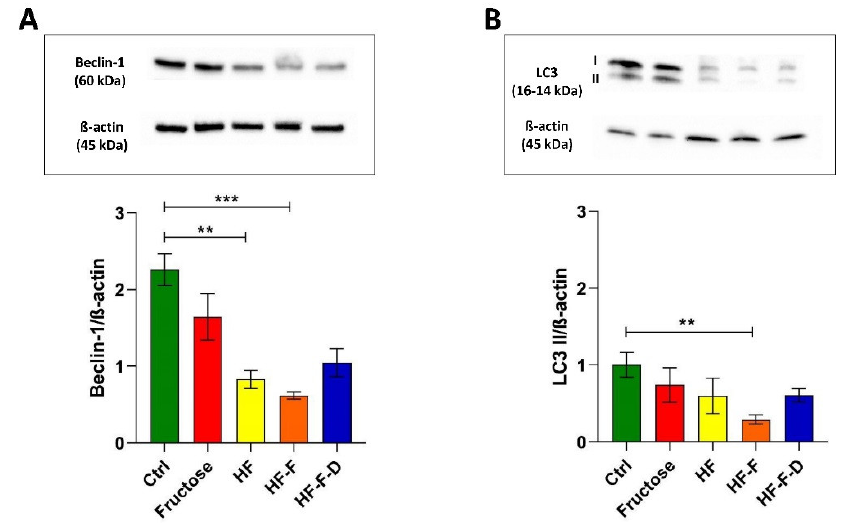
Figure 4. Western blot analysis of Beclin-1 ( A ), and LC3 ( B ) in liver samples from Ctrl, Fructose, HF, HF-F, and HF-F-D rats, with each group consisting of four rats. Data were analyzed by Kruskal–Wallis analysis of variance and Dunn’s Multiple Comparison Test (** p < 0.01; *** p < 0.001).